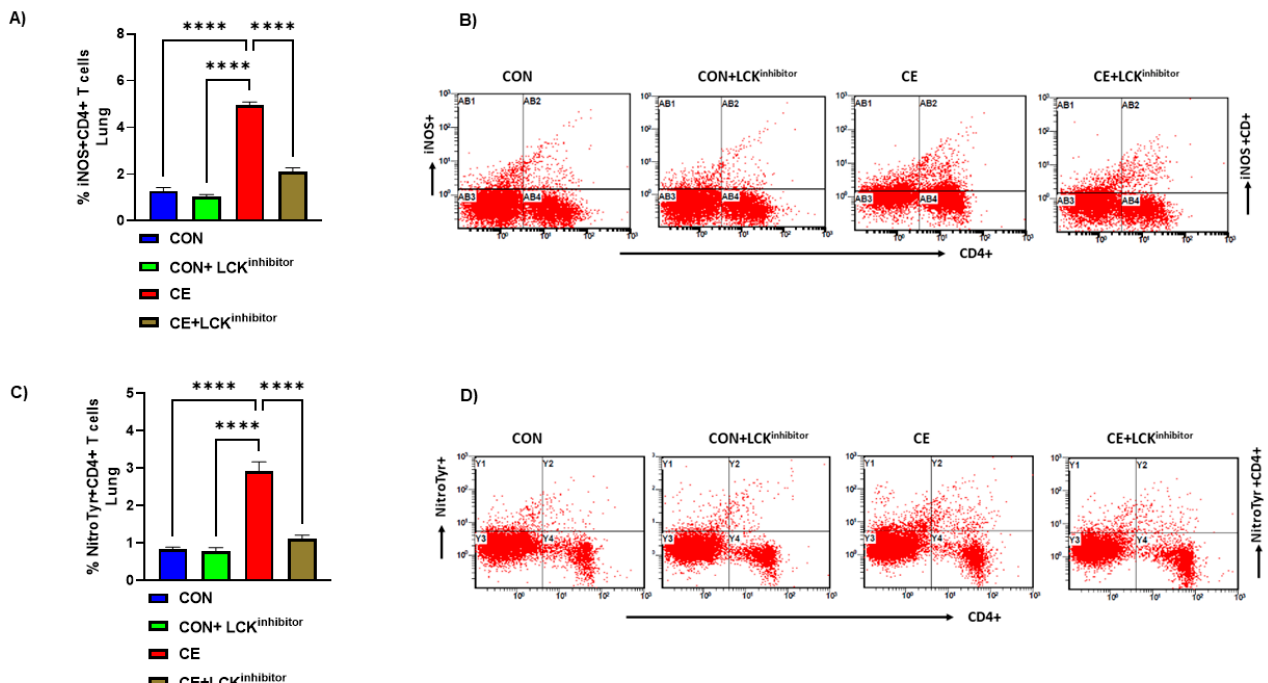
Figure 7. Attenuation of iNOS and nitrotyrosine in CD4+ T cells by LCK inhibitor in CE-exposed allergic mice. ( A ) % iNOS+CD4+ T cells, ( B ) Flow plot with representative depiction of double positive immunostaining in CD4+ T cells, i.e., iNOS+ immunoreactivity in CD4+ T cells, ( C ) % NitroTyr+CD4+ T cells, and ( D ) Flow plot with representative depiction of double positive immunostaining in CD4+ T cells, i.e., NitroTyr+ immunoreactivity in CD4+ T cells. Data are presented as mean ± SE, n = 6/group. **** p <